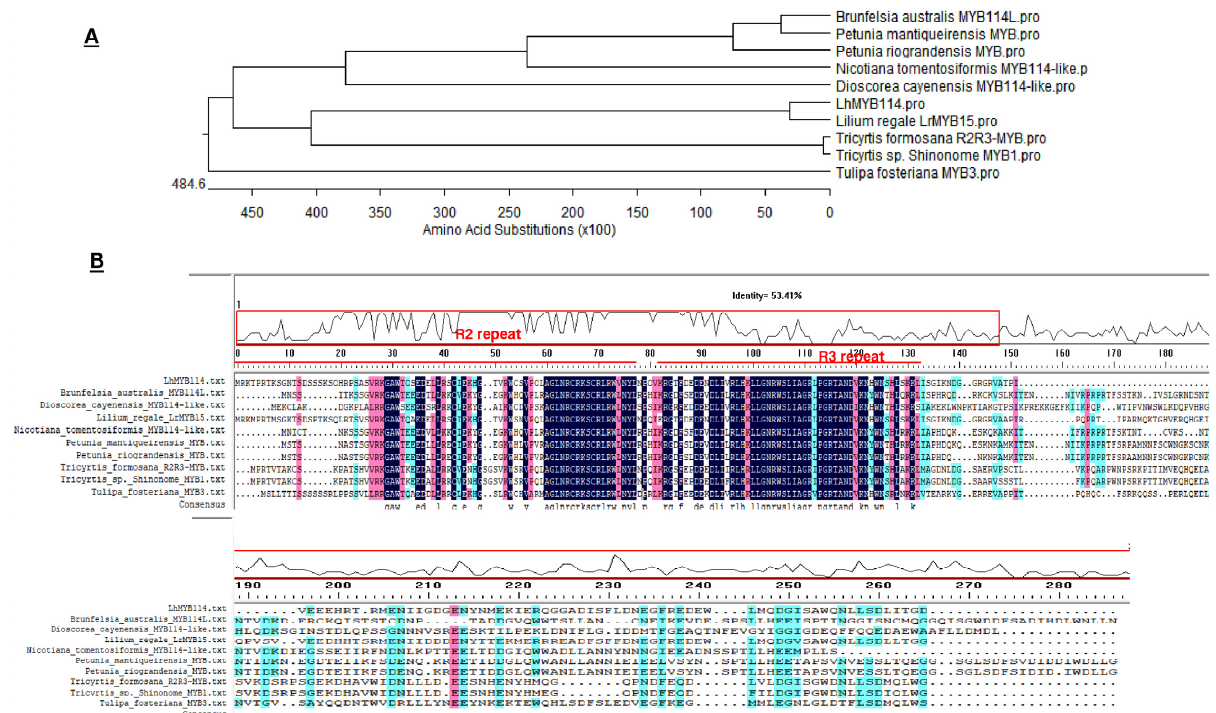
Figure 5. Amino acid sequence alignment of LhMYB114 . ( A ) The phylogenetic analysis of LhMYB114 with homologous genes related to anthocyanin biosynthesis. ( B ) The important domain analysis of LhMYB114 . Color represents amino acid sequence is high similarity, including pink, blue, cyan. 3.5. The Expression Analysis of Three Key Genes Associated with Anthocyanin Metabolism in Flower Buds